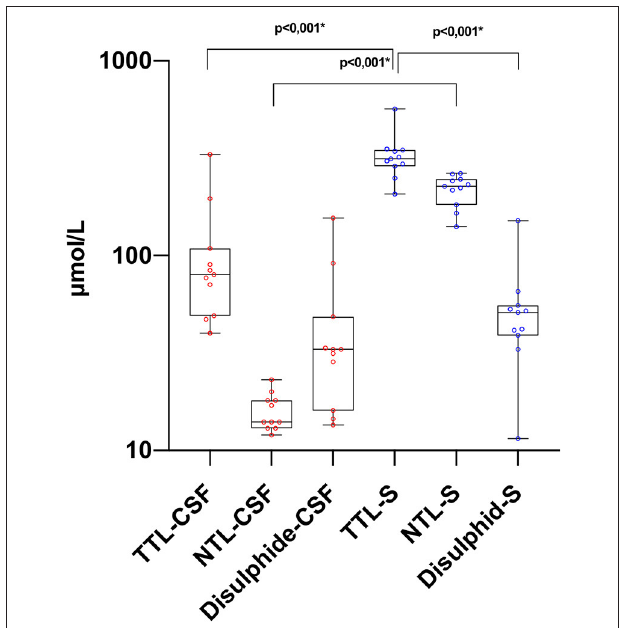
FIGURE 1 | Thiol levels in paired CSF and serum samples. TTL, total thiol; NTL, native thiol; CSF, cerebrospinal fluid. *The statistical significance is marked with asterisks (Mann–Whitney U